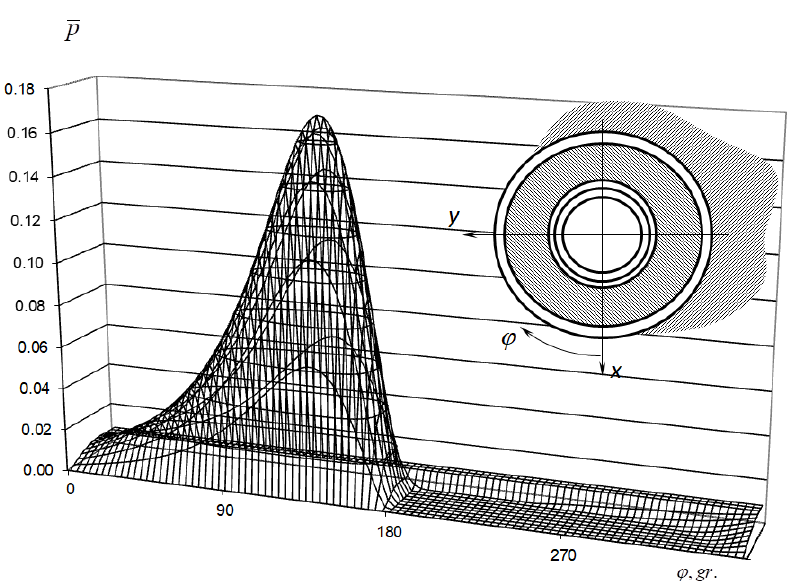
Figure 7. Diagram of hydrodynamic pressures in the lubricating layer with the circumferential groove.